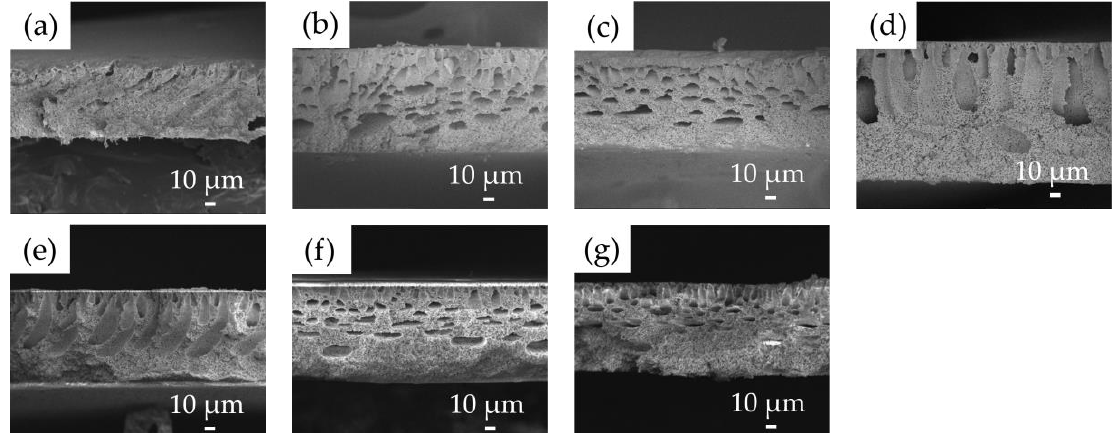
Figure 4. FE-SEM images of top surface of flat-sheet membranes with different PVDF, LiCl concentration and non-solvent compositions: ( a ) (S1) PVDF 14 wt.% with water, ( b ) (S2) PVDF 14 wt.% + LiCl with water, ( c ) (S3) PVDF 16 wt.% + LiCl with water, ( d ) (S4) PVDF 18 wt.% + LiCl with water, ( e ) (S5) PVDF 16 wt.% + LiCl with water (90%) + EtOH (10%), ( f ) (S6)